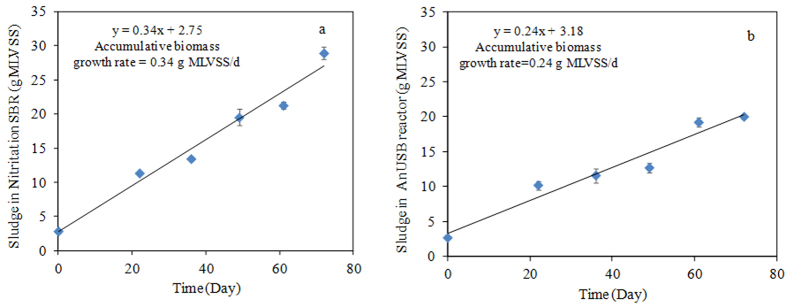
Accumulative biomass in terms of g MLVSS during Nitritation-TDD system operation.(a) sludge production in nitritation SBR was calculated as accumulative biomass growth rate (g MLVSS/d) ÷ average ammonia removal ratea; (b) sludge production in AnUSB reactor was calculated as accumulative biomass growth rate (g MLVSS/d) ÷ average NOx− (NO2− + NO3−) removal rateb. aAverage ammonia removal rate = 72 mg NH4+-N/L × 1 L × (24 h/day ÷ 2 hHRT)/1000 = 0.864 g NH4+-N/d. bAverage NOx− (NO2− + NO3−) removal rate = 45.06 mg NOx−-N/L × 1.2 L × (24 h/day ÷ 2 hHRT)/1000 = 0.649 g NOx−-N/d.